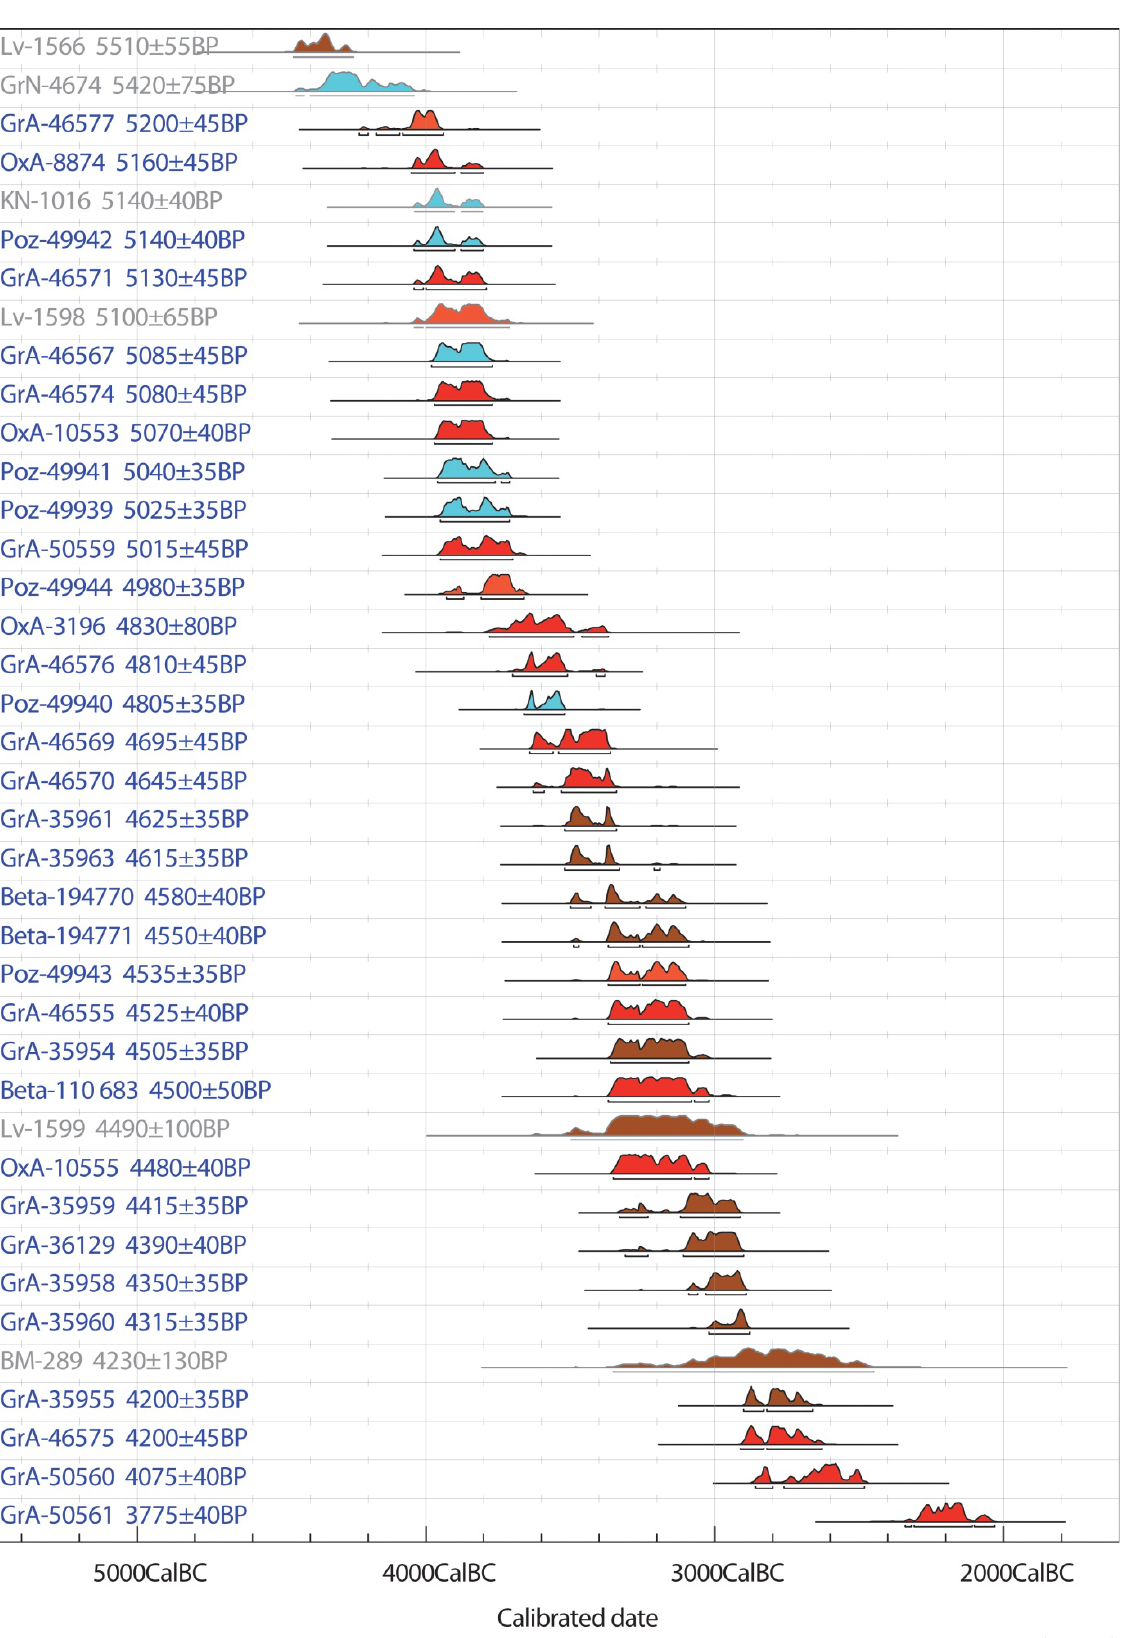
Figure 2. Radiocarbon dates of the Neolithic Flint Mines of Spiennes. Dates obtained on deer antler (brown), wood charcoal (blue), bone (orange), human bone (red); light grey outline for conventional radiocarbon dates, dark blue outline for AMS dates. Graphics by I. Jadin, Royal Belgian Institute of Natural Sciences. (IntCal 13 atmospheric curve (Reimer et al. 2013); OxCal v3.10 Bronk Ramsey (2005); cub r:5 sd:123 prob usp